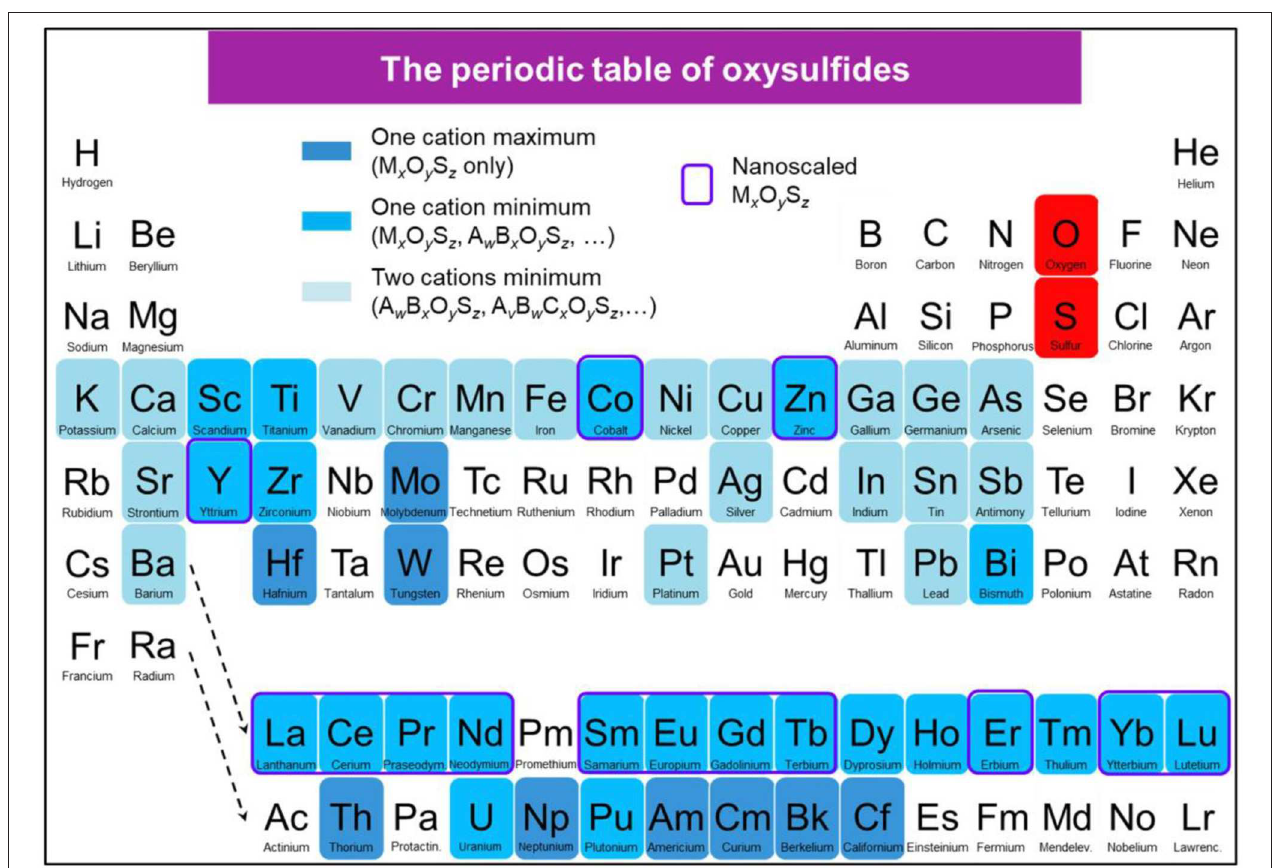
FIGURE 5 | Periodic table showing the reported oxysulfide compounds. In blue are indicated the elements that can be found in synthetic or natural oxysulfides. Blue shades indicate the compositions (ternary, quaternary, and more) that can be achieved for each element. Surrounded in violet are the elements for which M x O y S z nanoparticles were reported.